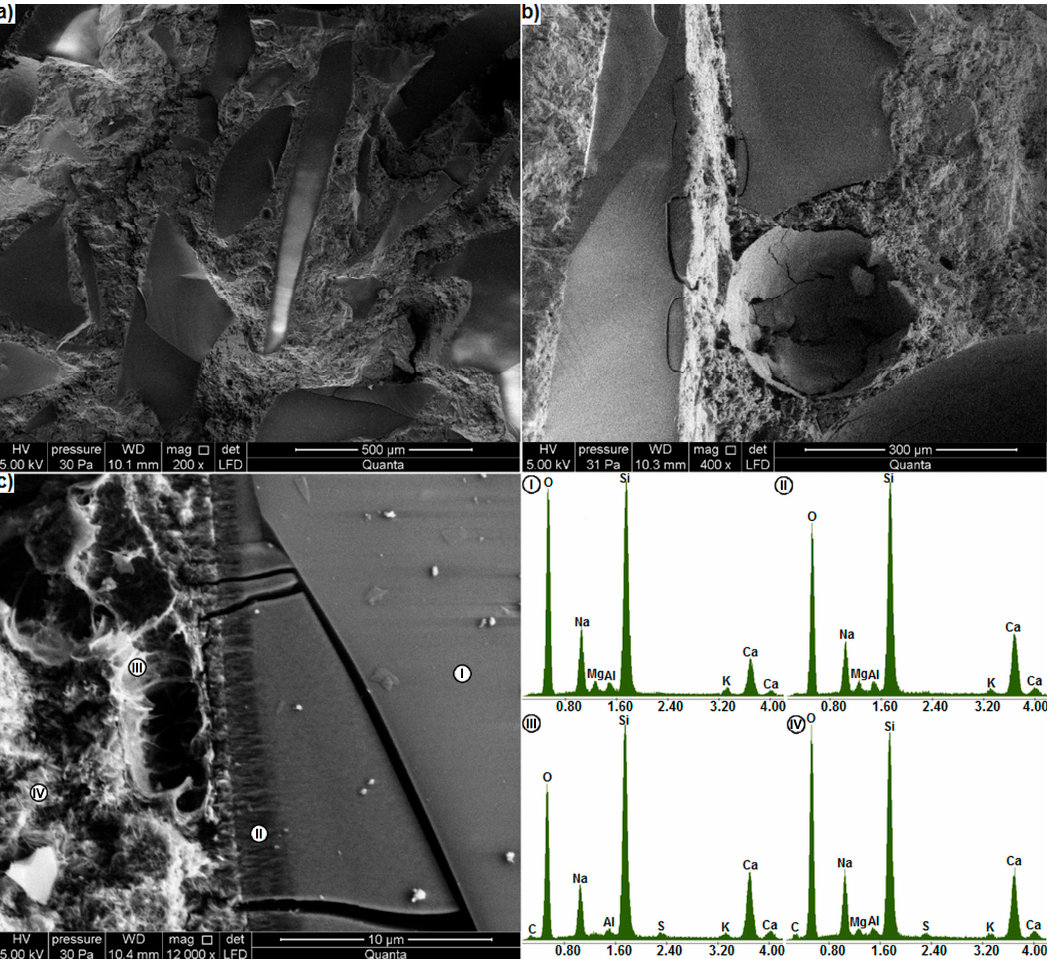
Figure 7. Mortar microstructure after 14 days of ASTM C 1260 test (SE). ( a ) General view, ( b ) cracked glass particles, ( c ) changes on the cracked glass particle surfaces, with EDS analysis in points I, II, III and IV.